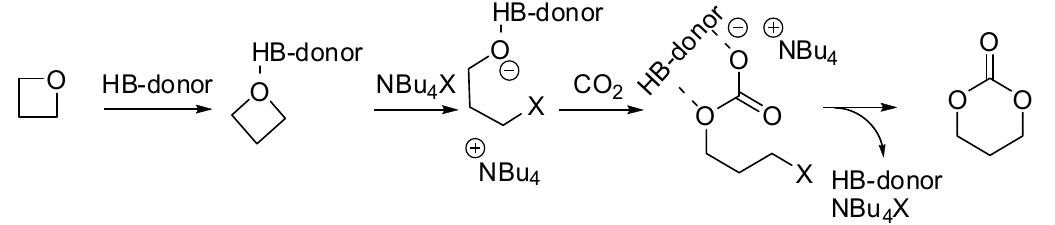
Scheme 9. Mechanism of the reaction of oxetane with CO